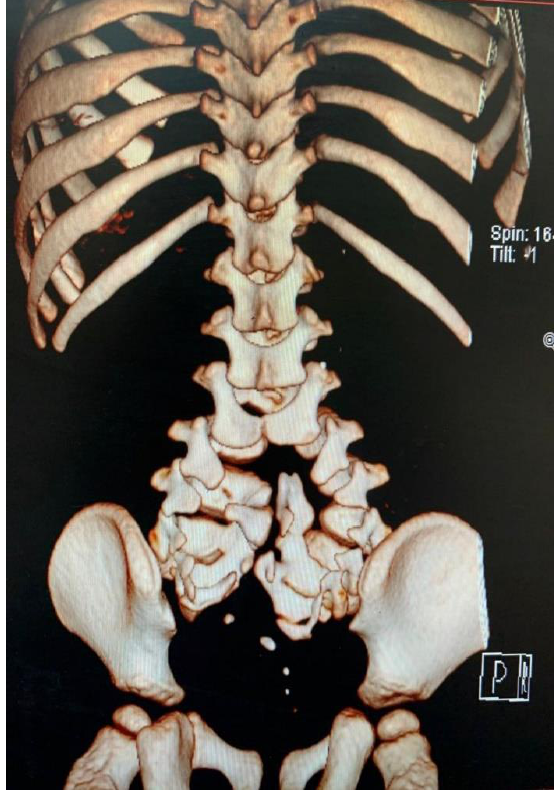
Figure 2. Three-dimensional reconstruction of computed tomography of the spine from mid-thoracic region to sacrum reveals duplication of the vertebral column from lumbar vertebrae 3 to the coccyx.